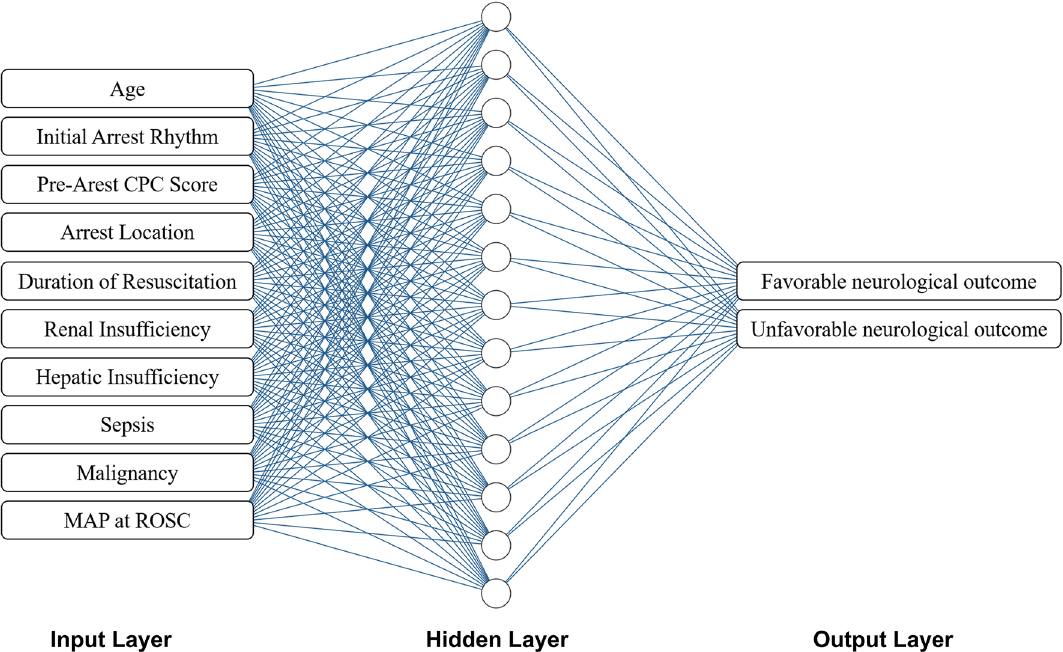
Figure 1. Artificial neural network (ANN) model in the present study. Schema showing the input, hidden, and output layers of the ANN model. The number of neurons in the hidden layer were set empirically and ranged from 1 to 50. The output layer contains two neurons—the favorable and unfavorable neurological outcome at hospital discharge. ANN artificial neural network, CPC cerebral performance category, MAP mean arterial pressure, ROSC restoration of spontaneous